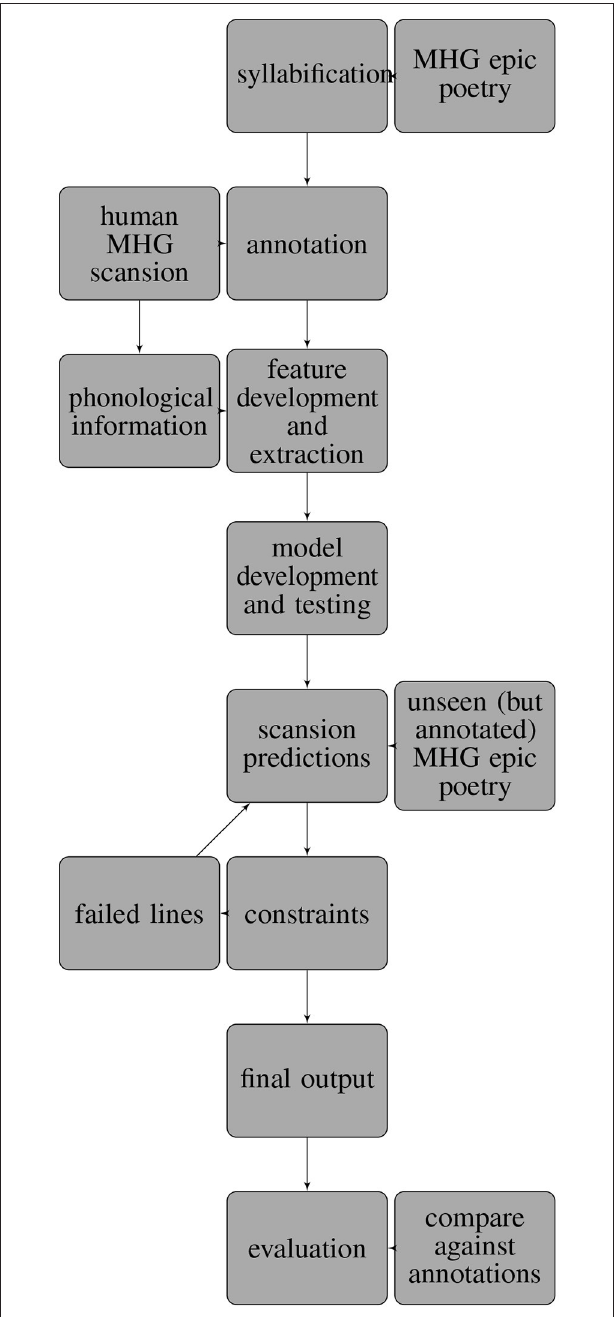
If the line fails any of the above tests, it is sent for further processing, where, depending on the phonology of the syllables and the rules above, all phonologically possible metrical values as well as the calculated marginal probabilities are combined into every possible sequence for all the syllables in the line. Illegal combinations according to the tests above are ruled out of the set, and the set is then ranked by overall probability.